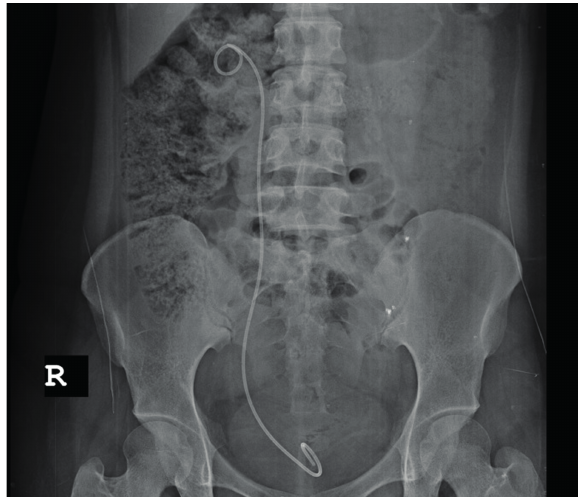
Figure 2 - Double J stent, was inserted to right ureter to achieve